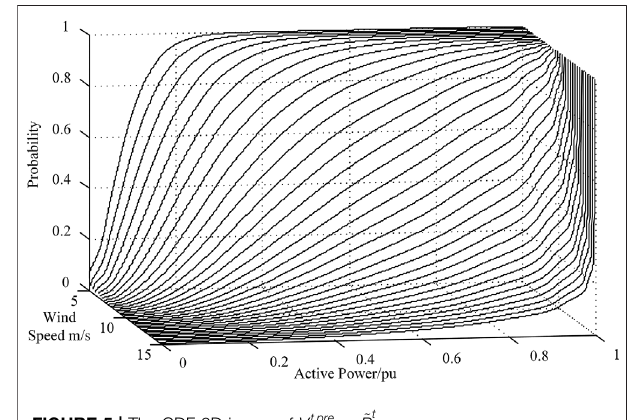
FIGURE 5 | The CDF 3D image of V t , pre speed − ~ P t WT .